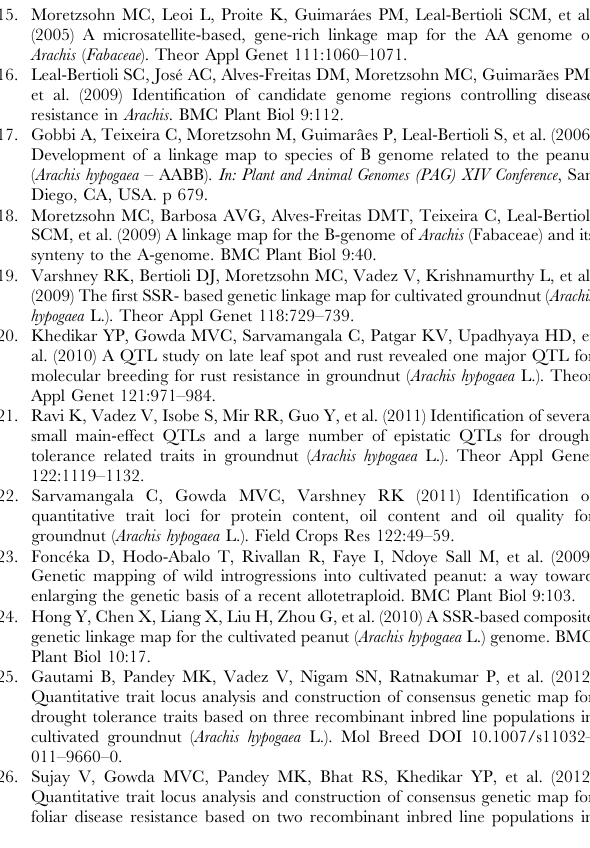
Table S4 Summary of comparative information be- tween tetraploid cultivated reference map and with diploid groundnut maps. This table provides comparative information on common markers between the tetraploid cultivated reference groundnut map with A-genome (Moretzsohn et al. 2005) and B-genome (Moretzsohn et al. 2009) diploid maps. Table S5 Genotyping scores for ten RILs and one BC mapping populations used to construct the reference consensus genetic map. This table provides detailed genotyp- ing data for all the 11 mapping populations used for the construction of reference genetic map. Table S6 List of the ‘‘A’’ and ‘‘B’’ genome specific markers mapped in the reference consensus genetic map. This table provides list of SSR markers identified specific to A and B genomes of the tetraploid